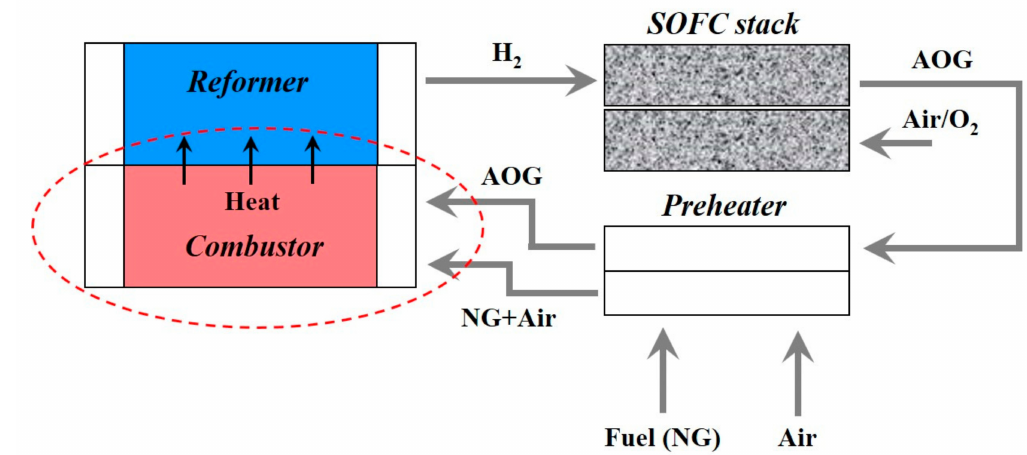
Figure 1. Schematic representation of the anode-o ff -gas (AOG) utilization concept. Component encircled in red (combustor) is modeled in the present